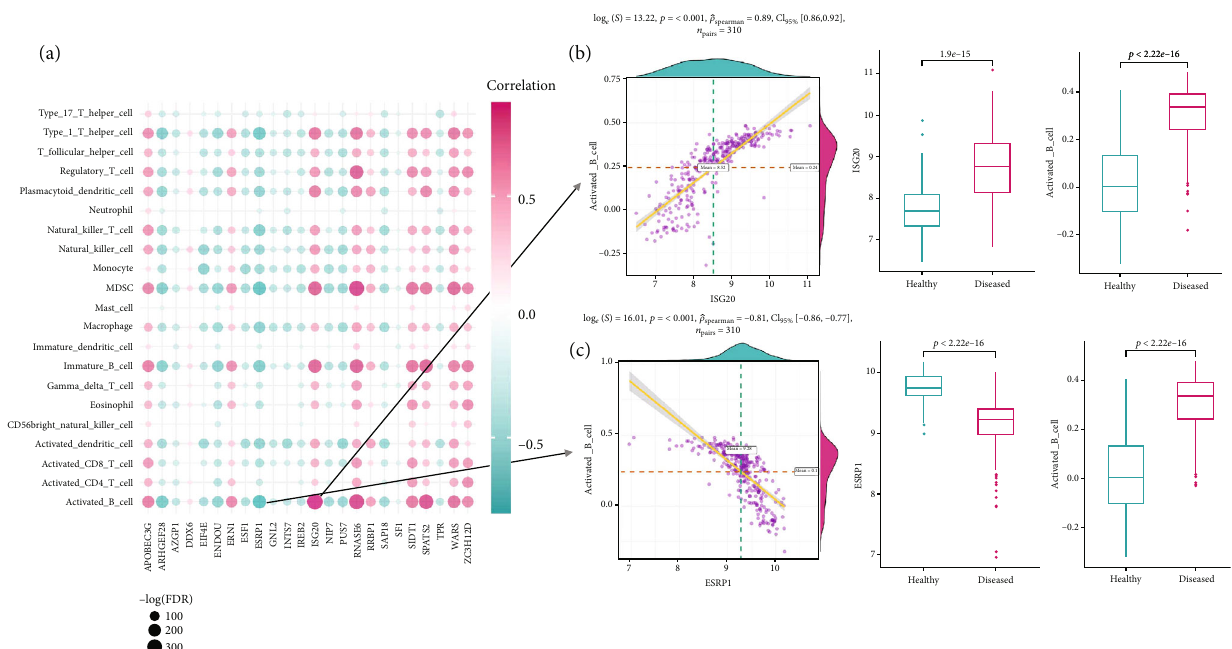
Figure 3: Immunocyte in fi ltration status in periodontitis and their correlation with RBPs. (a) Correlation analysis between relative enrichment score of immunocytes and RBP expression levels. (b) Dot plot and box plot reveal the relationship between the most positively correlated immunocyte-RBP pair, activated_B_cell, and ISG20, with a higher enrichment score of activated_B_cell and higher expression of ISG20 in periodontitis samples. (c) Dot plot and box plot reveal the relationship between the most negatively correlated immunocyte-RBP pair, activated_B_cell, and ESRP1. A higher enrichment score of activated_B_cell and lower expression of ESRP1 were observed in periodontitis samples.